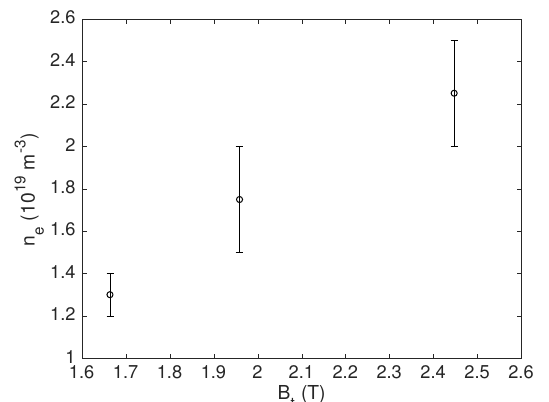
Figure 2: The upper electron density threshold (line aver- aged electron density along a chord close to the plasma center) for the occurrence of the ω pe bursts versus the toroidal magnetic field at major radius of 1.85 m.